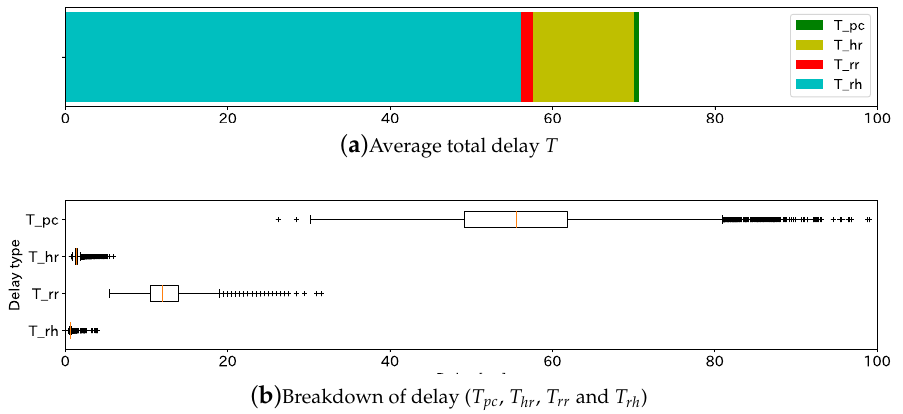
Figure 7. Total delay and the breakdown. (a) Average total delay T , (b) Breakdown of delay ( T pc , T hr , T rr and T rh